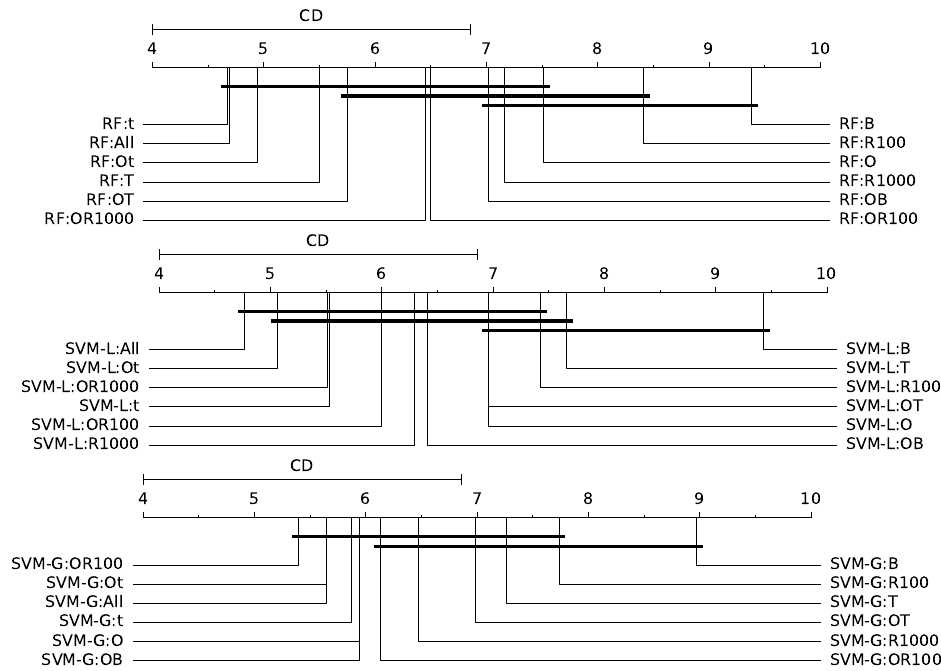
Figure 5. Critical difference diagrams for the Nemenyi test ( α =